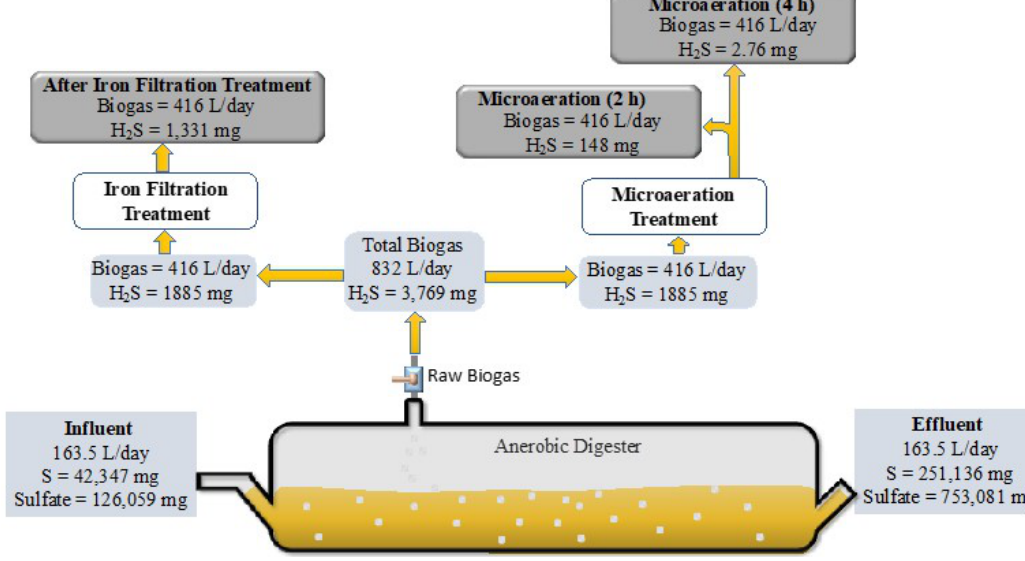
Figure 4. Schematic diagram of the sulfur mass balance.